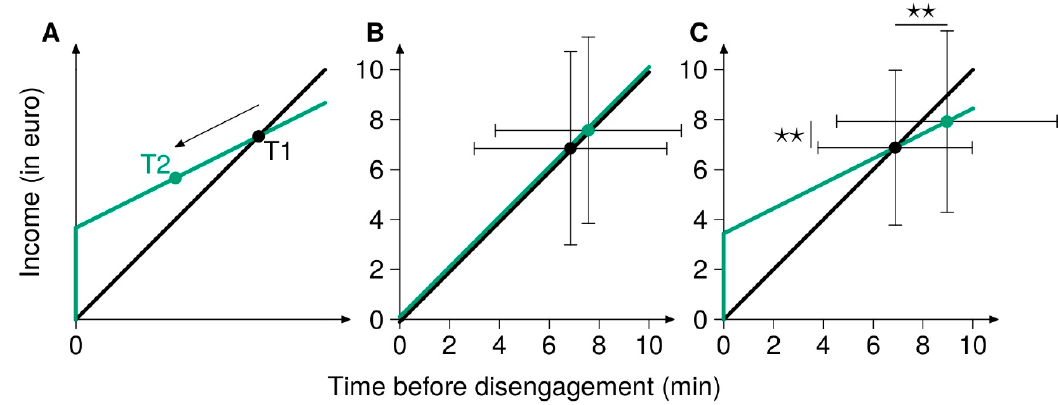
Figure 1. The utility of cognitive control. In this figure, adapted from Kool and Botvinik [29], the black and green dots correspond to the mean combination of income (in euro) and time (in min) before disengagement at t1 and t2, respectively. The black and green lines represent the mean budget constraint at t1 and t2, respectively. The budget constraint line corresponds to all the possible combinations of income and time before disengagement, in the given experimental context. The higher ordinate at the abscissa zero corresponds to the mean upfront payment. The error bars represent SD and the double five-pointed stars correspond to a p -value < 0.01. ( A ) Prediction of the iso–utility curve of the task with an ICWD condition at t2, according to the model of cognitive effort control [29]. ( B ) Results at t1 and t2 of the control group. ( C ) Results at t1 and t2 of the ICWD group.